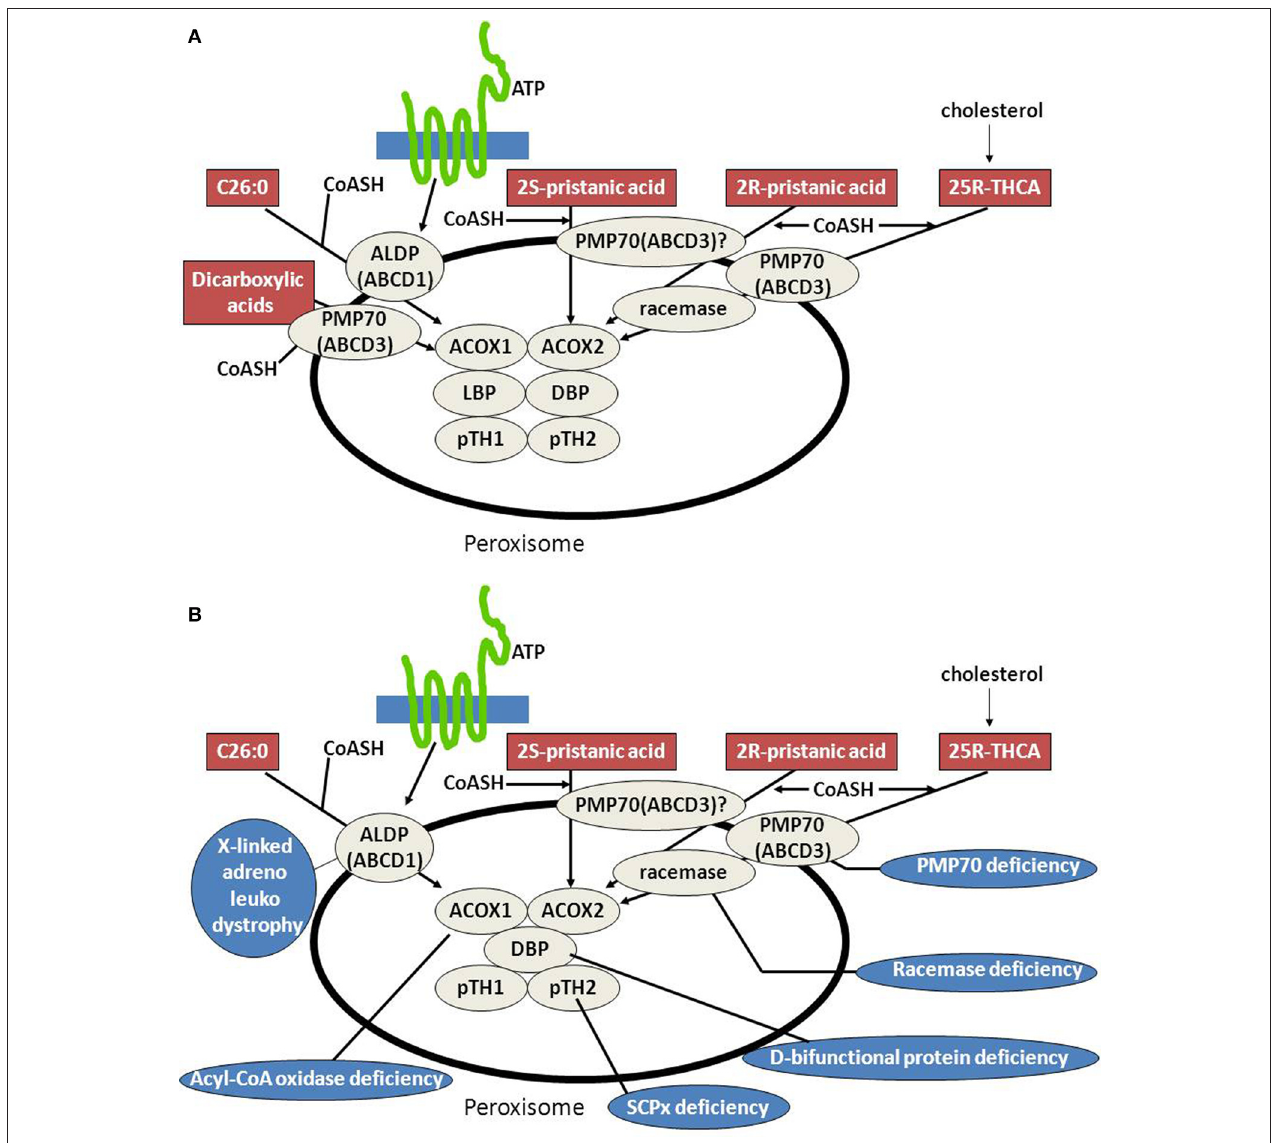
FIGURE 3 | Peroxisomes, fatty acid beta-oxidation and the human deficiencies of peroxisomal beta-oxidation. (A) Schematic diagram depicting the substrates known to be oxidized in peroxisomes exclusively and the transporters and enzymes involved in their degradation (see text for detailed information). (B) Schematic diagram depicting the substrates known to be oxidized in peroxisomes exclusively and the transporters and enzymes involved in their degradation and the human deficiencies in the peroxisomal beta-oxidation pathway so far identified (see text for more information).